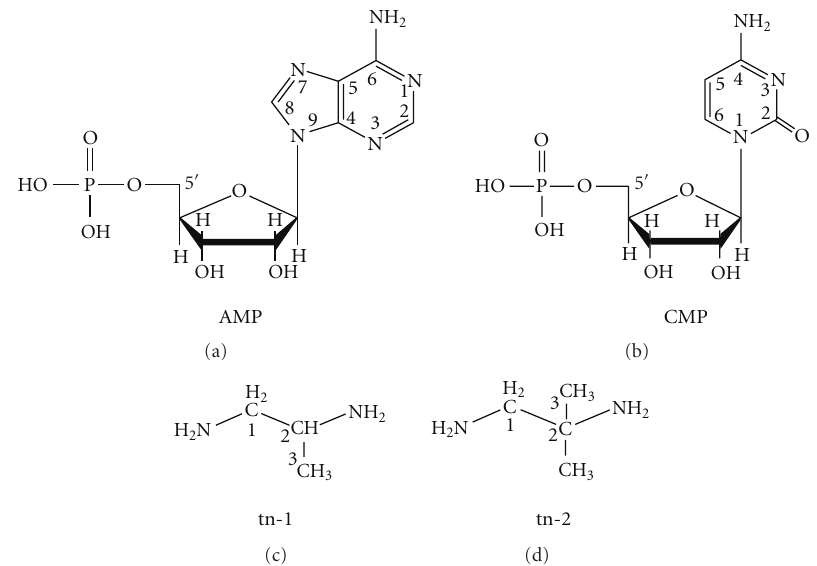
Figure 1: Chemical formulae of the bioligands studied.